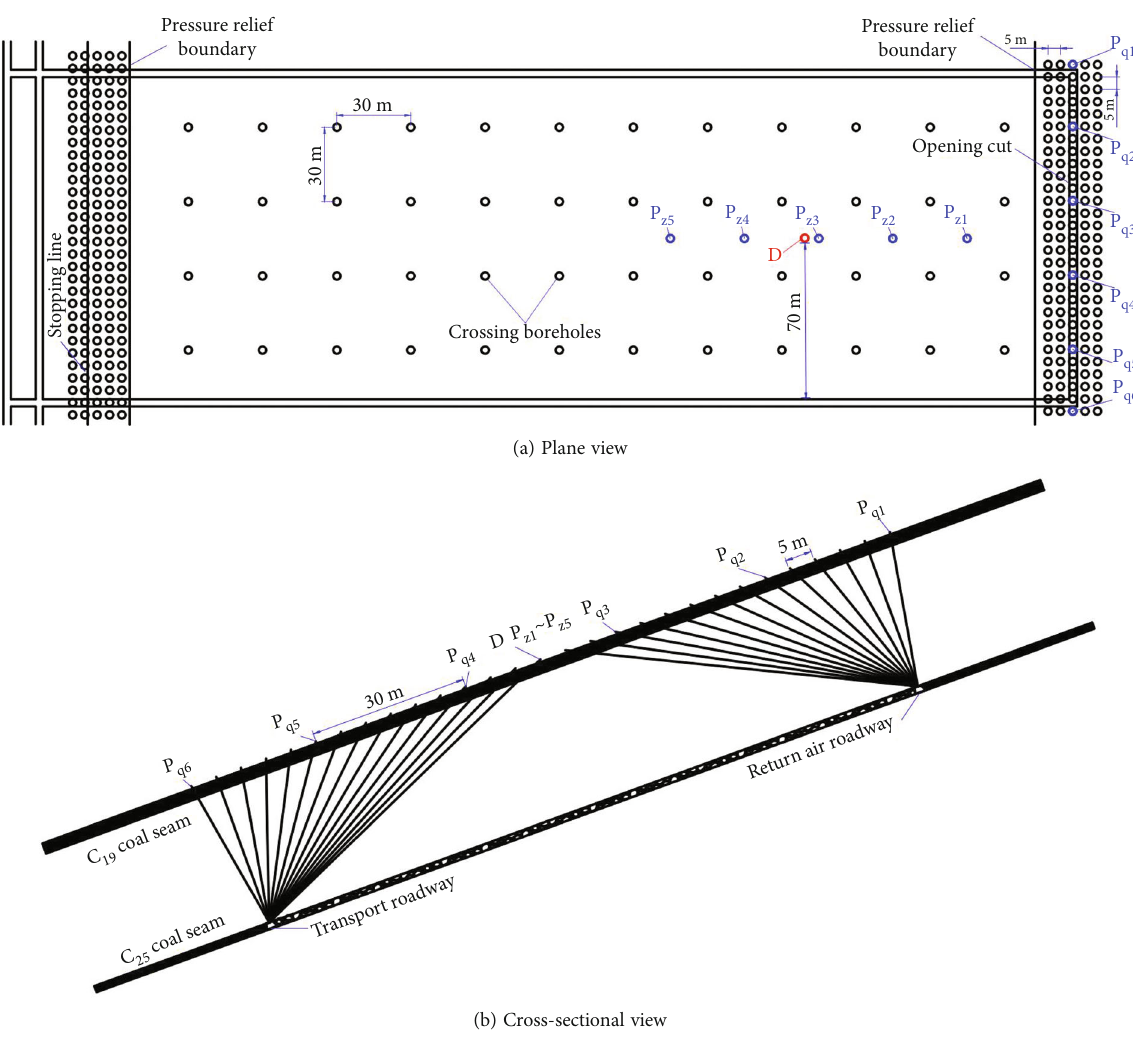
Figure 22: Layout of crossing Table 5: Residual gas pressure in inspection boreholes.